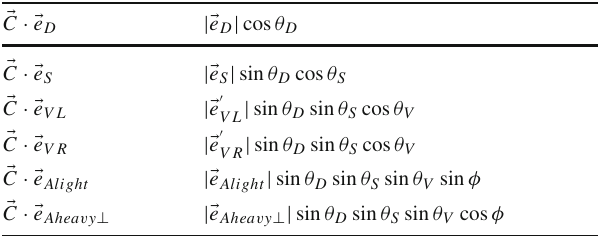
Table 2 Dimensionless operator coefficients expressed in the angular coordinates. The radial coordinate is 1 /(cid:4) 2 , θ I : 0 ..π and φ : 0 .. 2 π . LFV As discussed in Appendix 1, the (cid:7) e VL × (cid:7) e V R plane was projected to a line, deviations from which are measured by θ V . In general, the basis vectors { e A } are not unit vectors, and their normalisation is given in Table 5 and after Eq. (C.3) for the primed